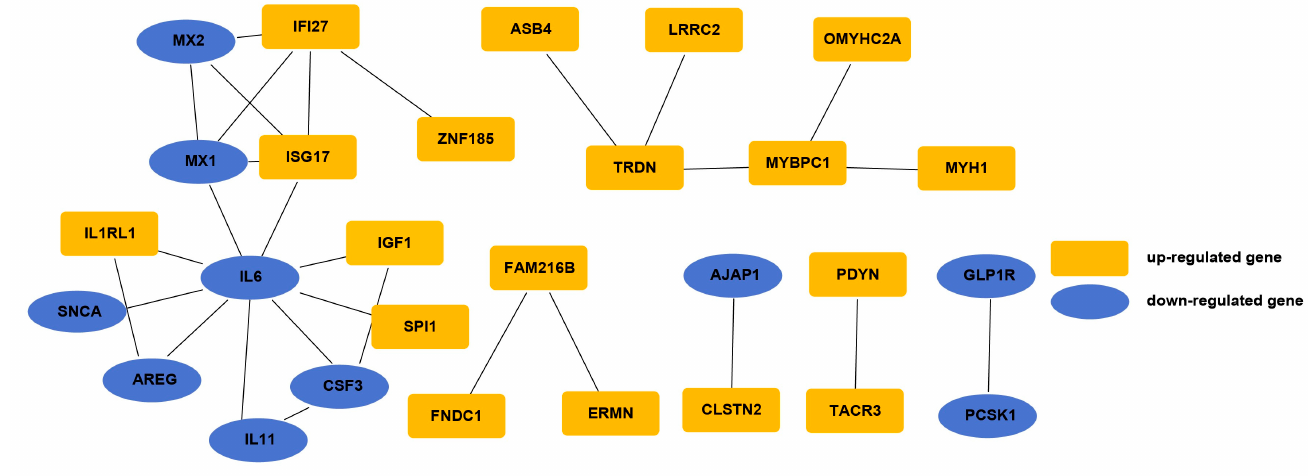
Figure 3. Top 50 most upregulated and downregulated DEGs from the protein–protein interaction (PPI) network. Blue nodes represent the downregulated DEGs, and the yellow nodes represent the upregulated DEGs.